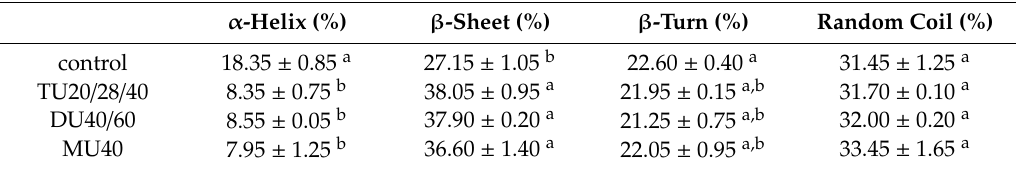
Table 2. E ff ects of online-US / T40 / pHS treatment at the frequency of TU20 / 28 / 40, DU40 / 60, and MU40 kHz on secondary structure of potato